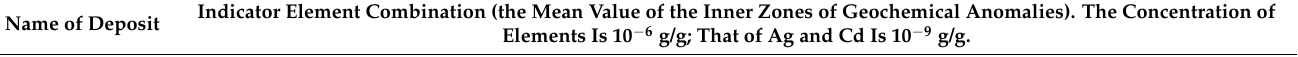
Figure 2. Geochemical contour map of the average contrast values of Pb–Zn–Ag–Cd. Table 2. The average concentrations of major indicator elements in the inner zone of geochemical anomaly of the typical